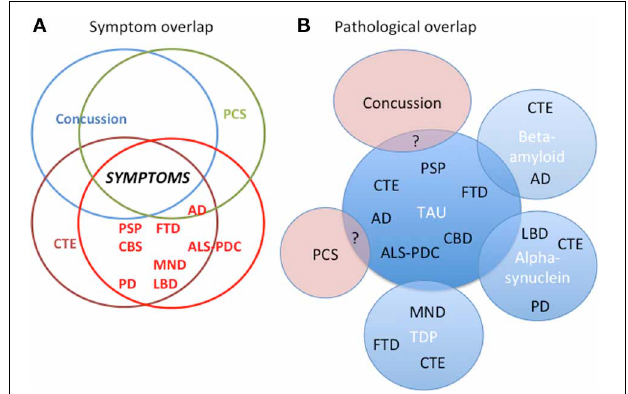
FIGURE 1 | The interrelationships between concussion, post-concussion syndrome (PCS), chronic traumatic encephalopathy (CTE), and all the neurodegenerative diseases. (A) There is considerable symptom overlap between concussion, PCS, CTE, and the neurodegenerative diseases. (B) Pathologically the relationship between concussion, PCS, CTE, and all the neurodegenerative diseases is unclear. In CTE there is substantial evidence for overlapping pathology of tau, TDP-43, amyloid, and alpha-synuclein with neurodegenerative diseases. In neurodegenerative diseases such as AD, PD, and LBD, there is also overlapping pathology. The pathology of concussion and PCS and their relationship to CTE remains to be explored. AD, Alzheimer’s Disease; ALS-PDC, amyotrophic lateral sclerosis-parkinson’s dementia complex (Guam); CBD, corticobasal degeneration; CBS, corticobasal syndrome; CTE, chronic traumatic encephalopathy; LBD, Lewy Body Disease; FTD, frontotemporal dementia; MND, motor neuron disease; PCS, Post-concussive syndrome; PSP, progressive supranuclear palsy; PD, Parkinson’s disease. “?” indicates uncertainty about